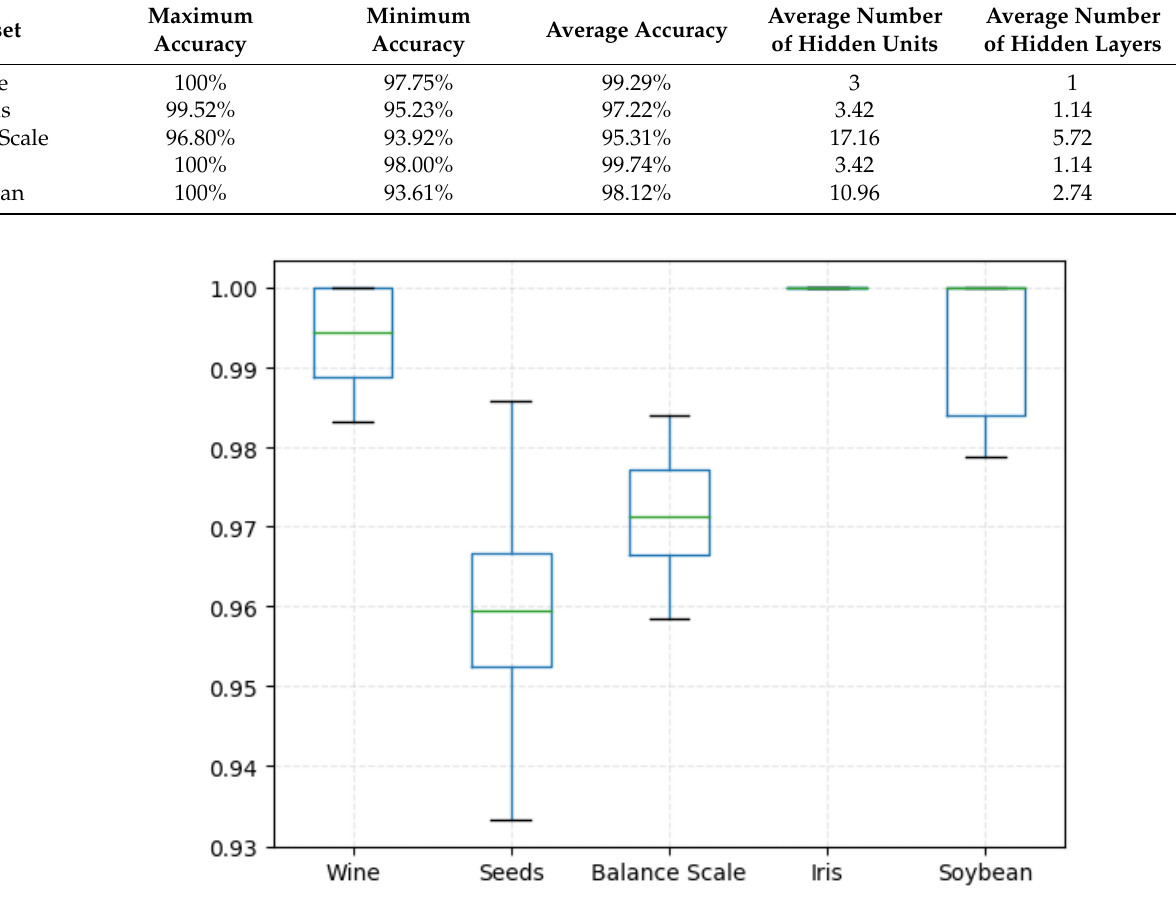
Figure 12. The distribution of the accuracy rates of the CCNN-jDE-B algorithm tests in each dataset.